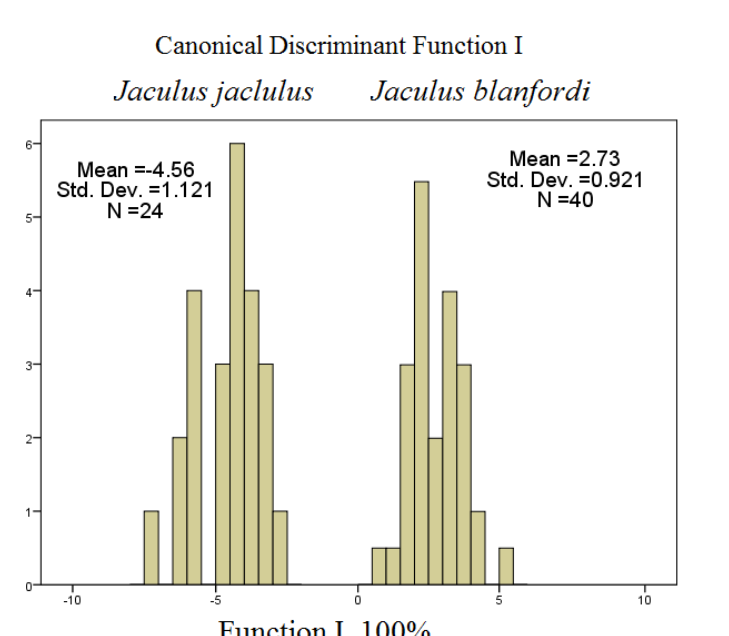
F IGURE 3. Scatter plot of CVA analysis, based on all measured morphometric variables of Jaculus .